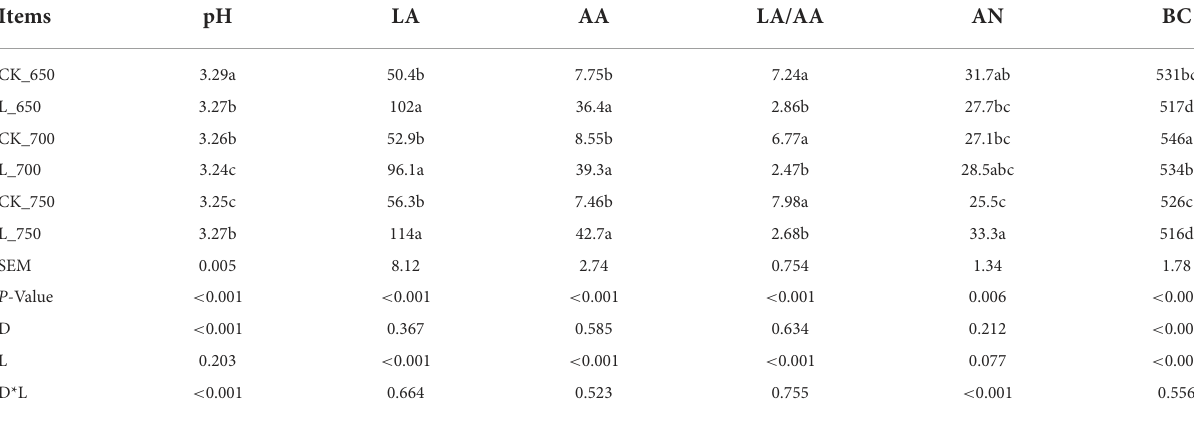
TABLE 3 pH, organic acid concentrations [g/kg dry matter (DM)], ammonia nitrogen/total nitrogen (AN, g/kg), and buffering capacity (BC, mE/kg DM) in sweet sorghum silages ( n = 4).